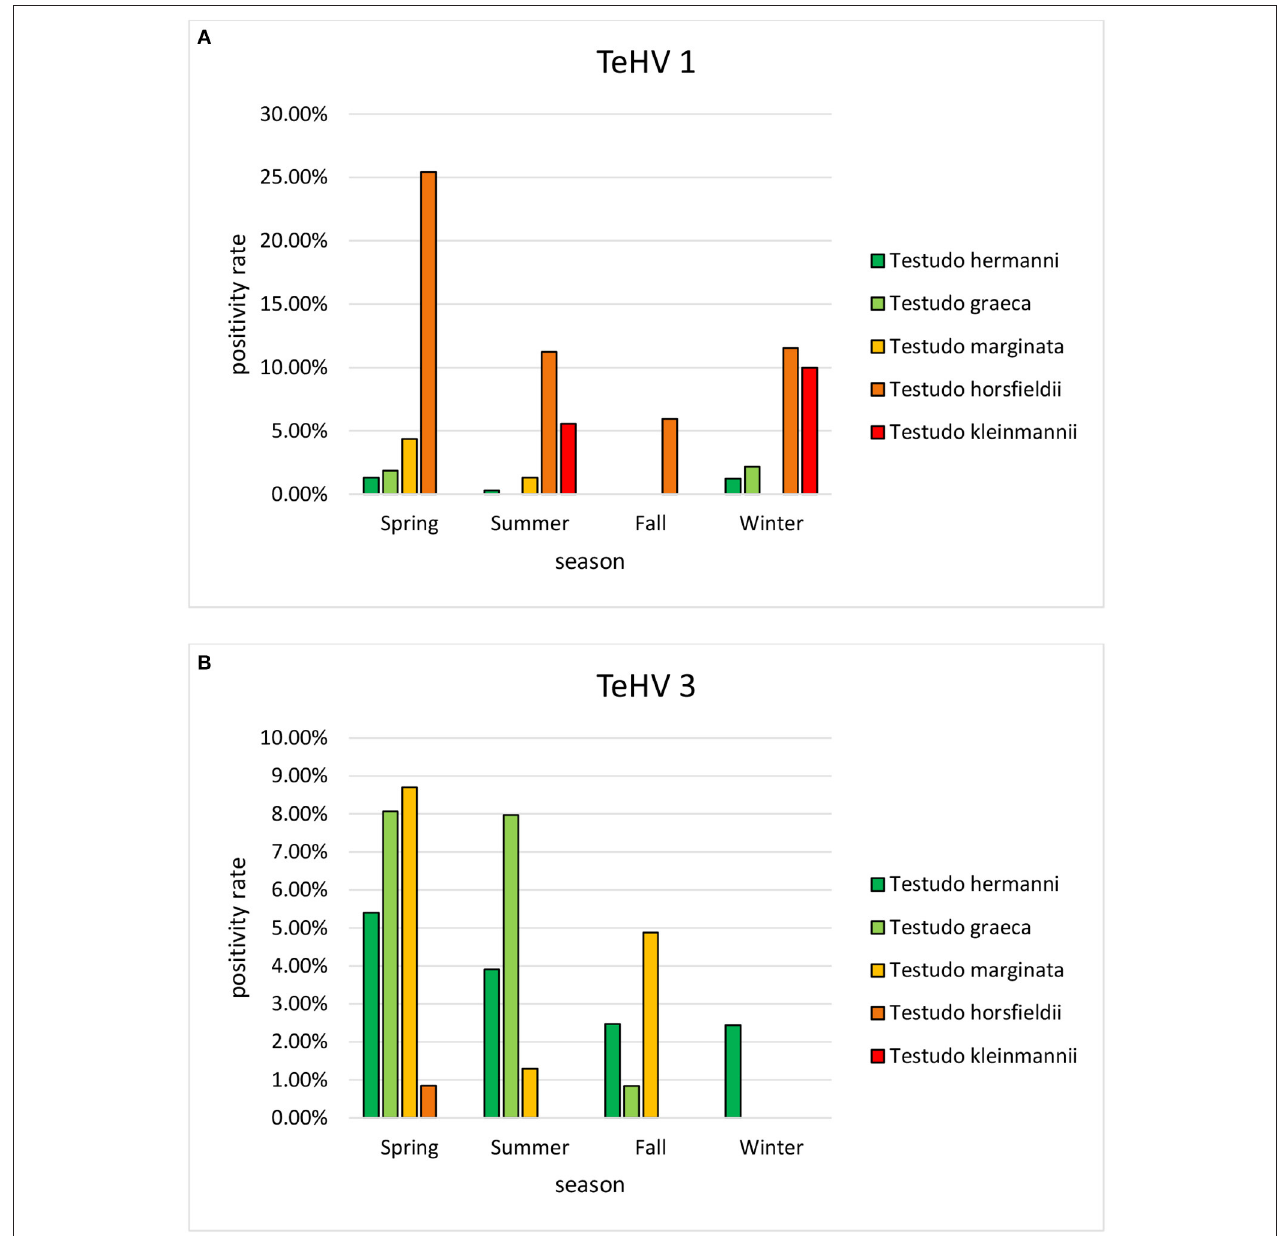
FIGURE 3 | Herpesvirus positivity rates in Testudo species (Hermann’s tortoises, T. hermanni , spur-thighed tortoises, T. graeca , marginated tortoises, T. marginata , Horsfield’s tortoises, T. horsfieldii , and Egyptian tortoises, T. kleinmanni) according to season ( A TeHV 1 and B TeHV 3).